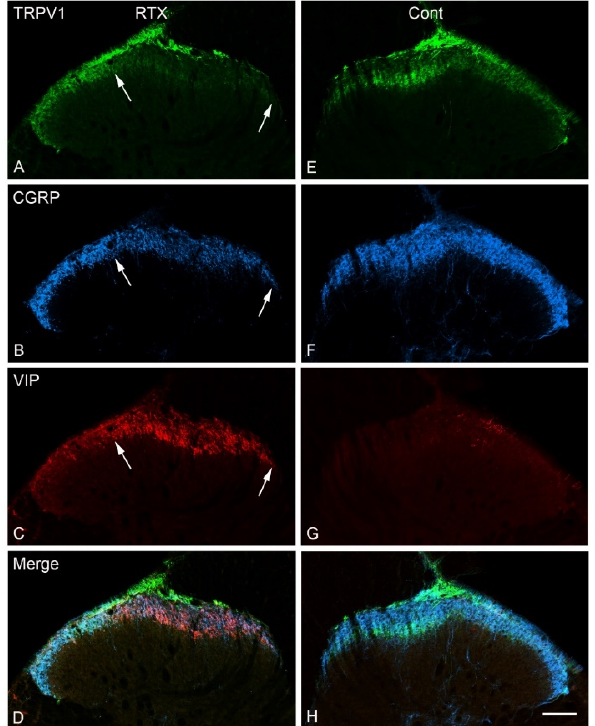
Figure 4. Confocal images of a transverse section of the L4 spinal segment showing TRPV1, CGRP